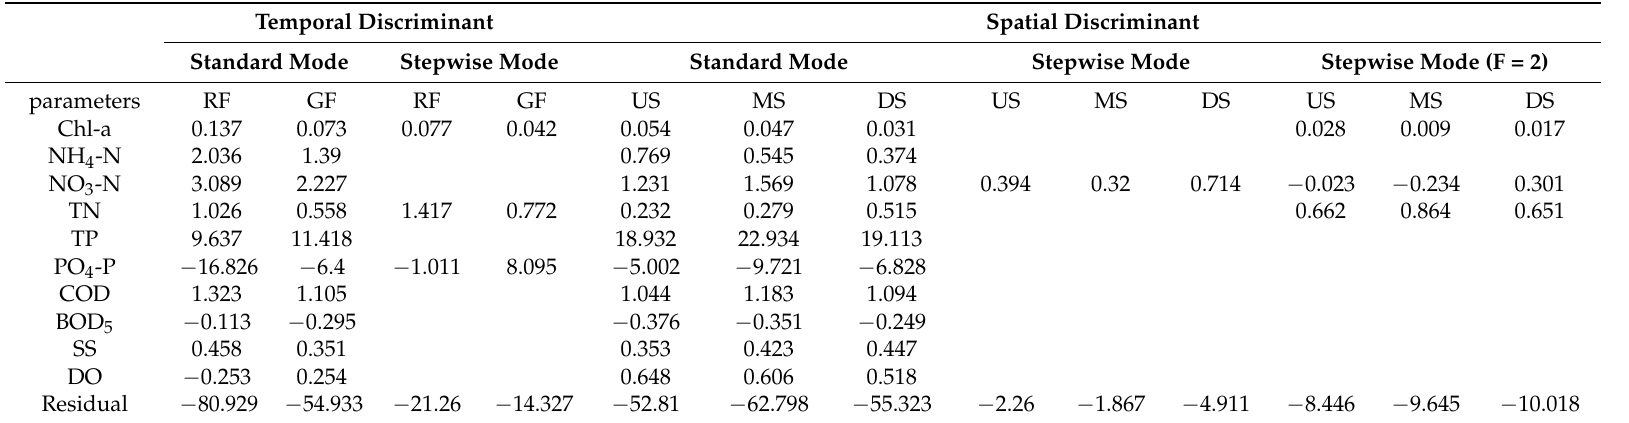
Table 3. Classification functions for discriminant analysis (DA) of temporal and spatial